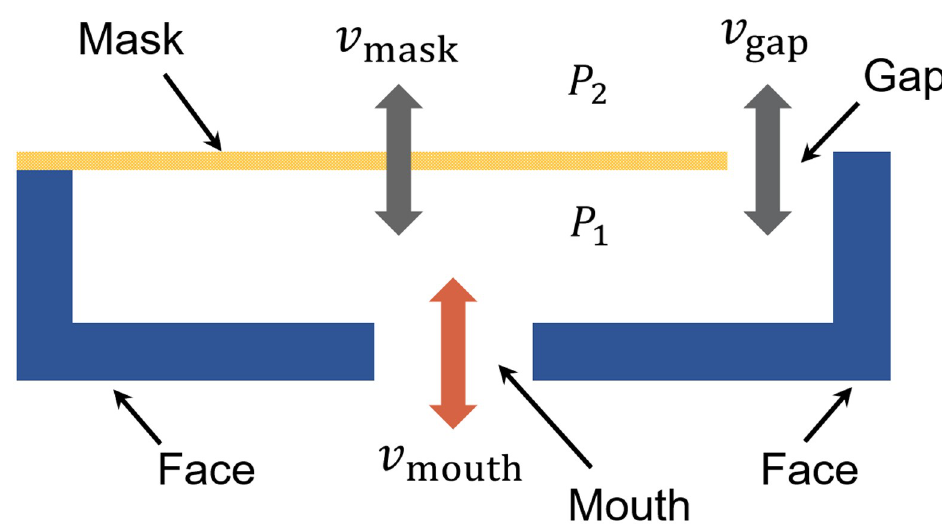
Fig 2. The model of the mask with face-seal